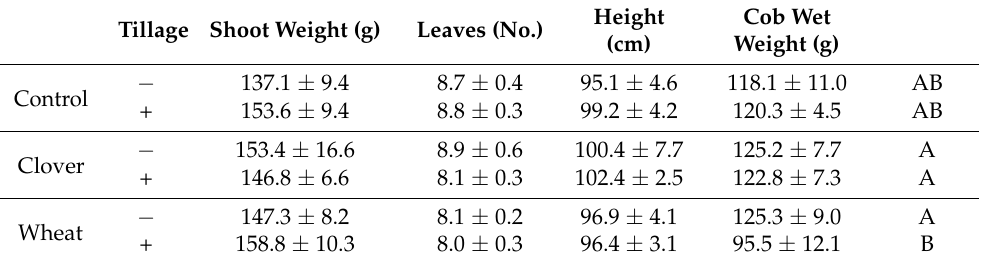
1 Values represent an average of 10–12 replications. If existing, statistically significant (one-way ANOVA, p < 0.05) differences between treatments at the same measures are indicated by different letters Clover